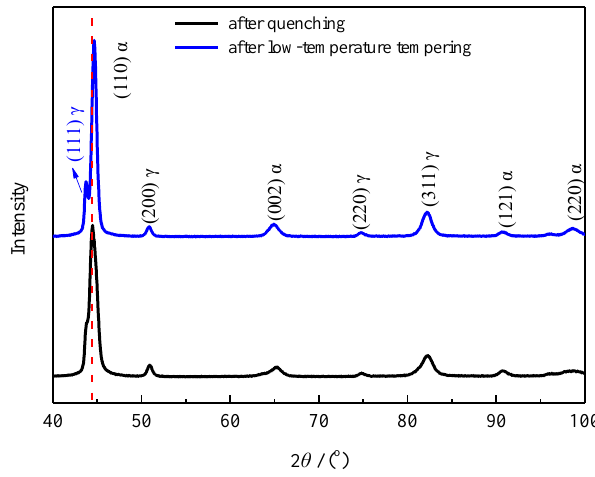
Figure 9. XRD pattern of the carburized layer at a 0.3 mm depth for process 1.